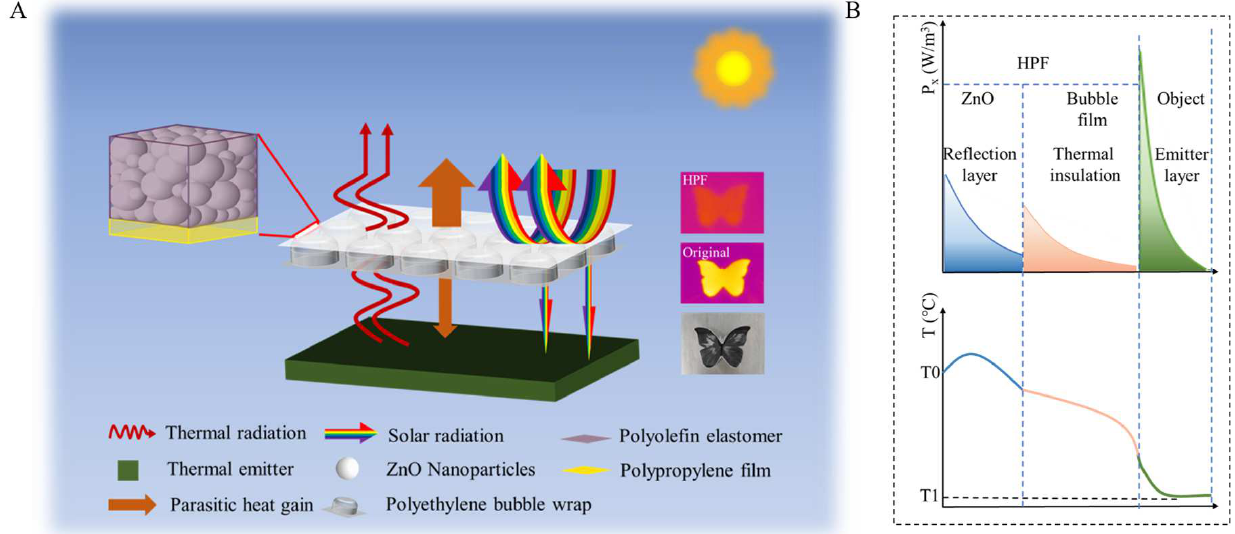
Figure 1. ( A ) Structural of HPF (ZnO film top layer and air bubble film bottom layer). ( B ) The cooling trend graph: The radiated power of each part of the material is distributed exponentially along the thickness direction.